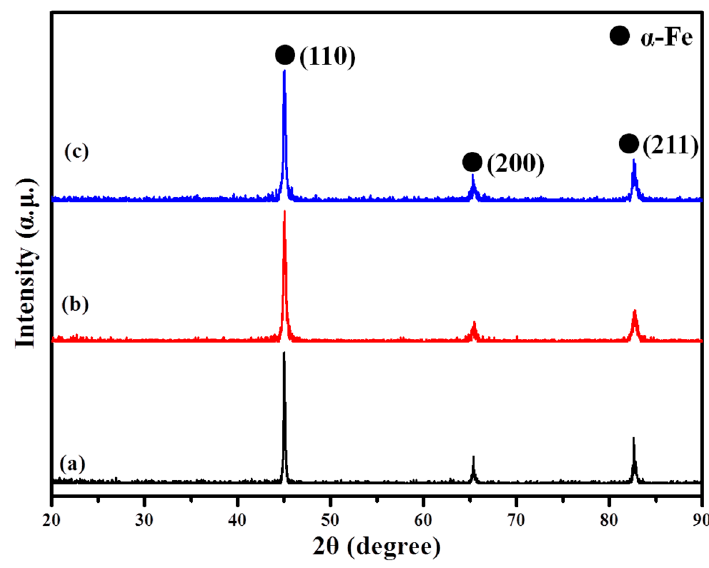
Figure 3. The XRD patterns of the powders ( a ) pure iron; ( b ) hybrid coating via the ball-milling method with 8% Al 2 O 3 ; ( c ) hybrid coating via the sol–gel method with 8% Al 2 O 3 .